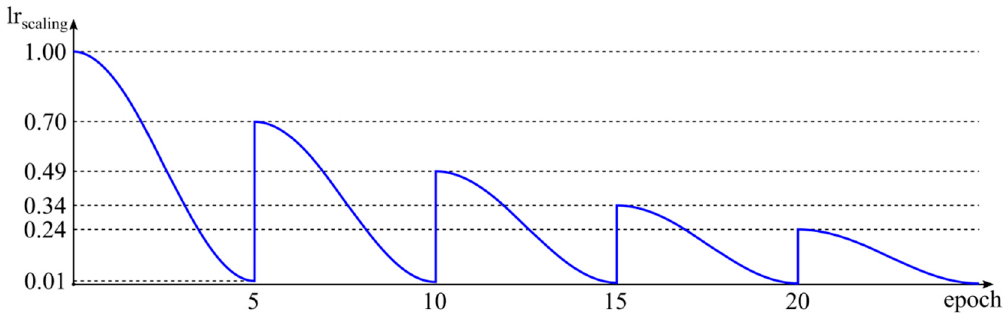
Figure 9. Cosine annealing schedule used for scaling the initial learning rate during the training.